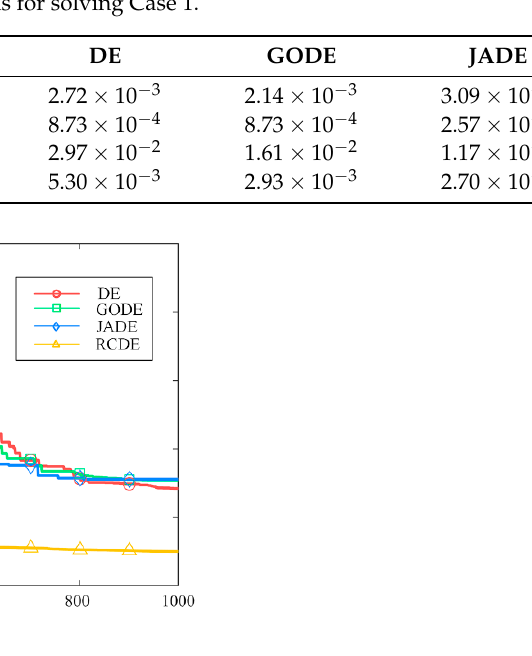
Figure 9. Convergence curves of the four algorithms in Case 1.